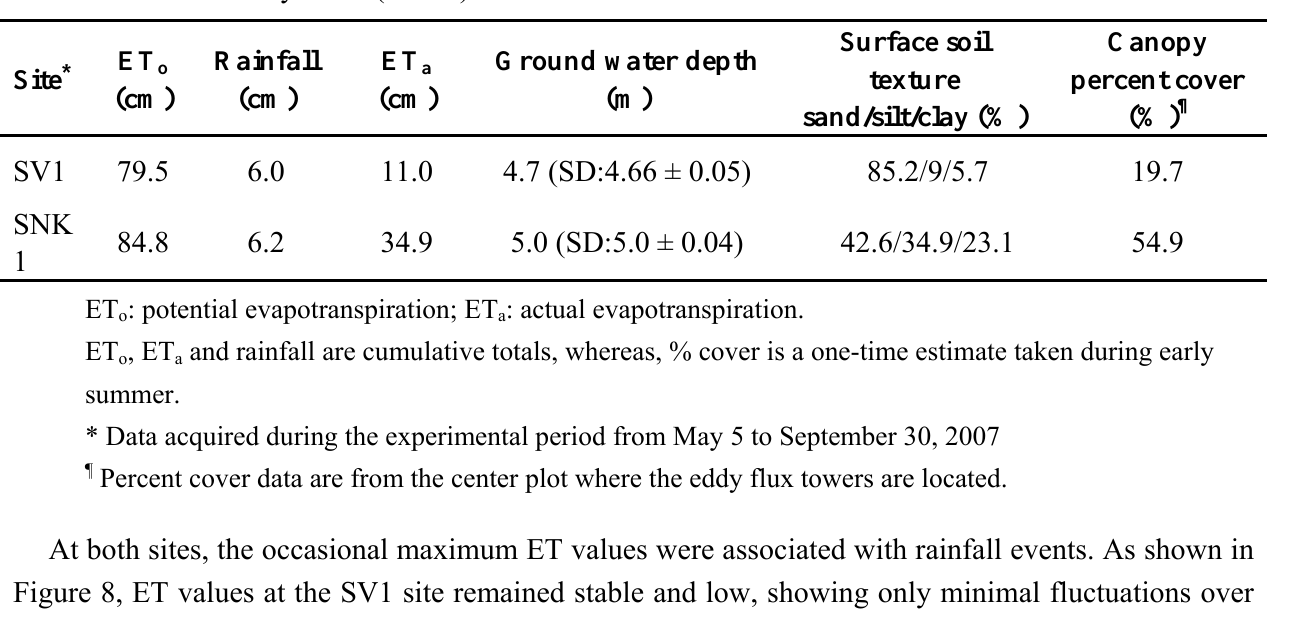
values a values are from Snake Valley 1 site a